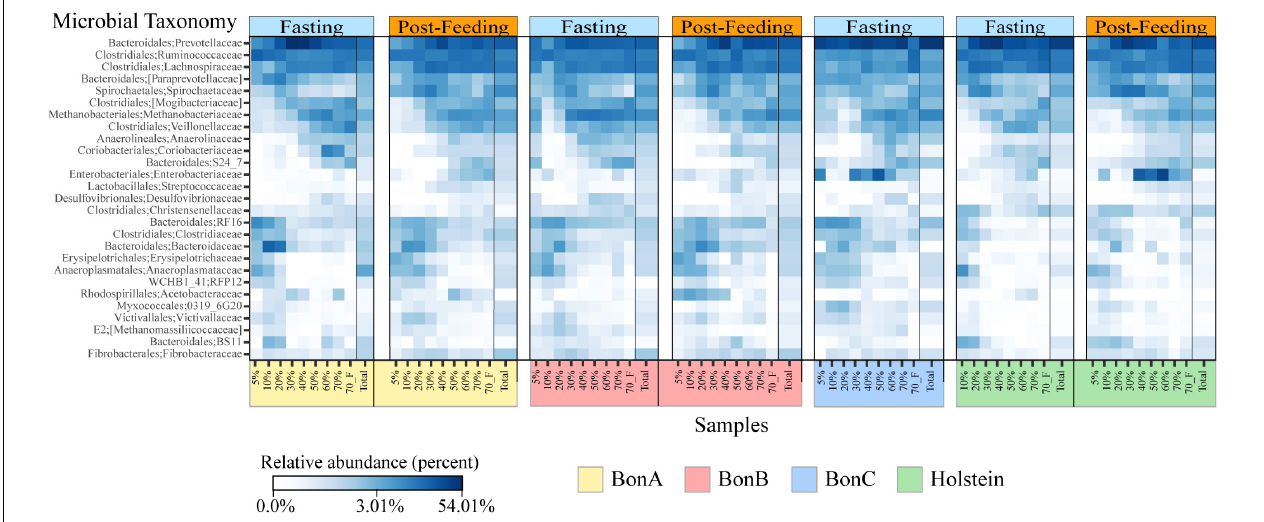
FIGURE 4 | Heatmaps depicting relative abundance of the bacterial families across the sucrose density gradient fractions and the total sample for the BON-A (A) , BON-B (B) , BON-C (C) , and Holstein (D) at the time of fasting and post feeding. Note that no post-feeding sample was obtained for the BON-C. Relative abundance (percentage) is shown in a log scale to help visualize changes in the community composition of families that are not highly abundant. Families present in the four animals are highlighted in red. A black line divides the Total sample from each of the